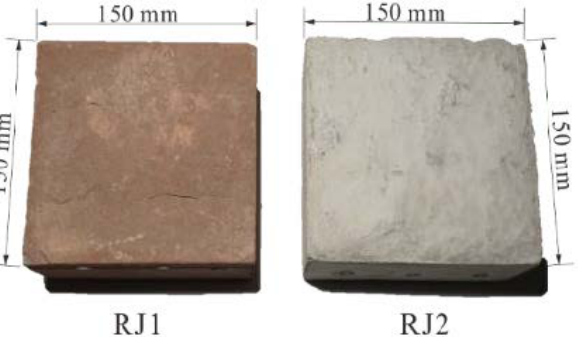
Figure 2. Two rock joint specimens used for 3D reconstruction, RJ1 is a natural red sandstone rock joint specimen, RJ2 is an artificial rock joint